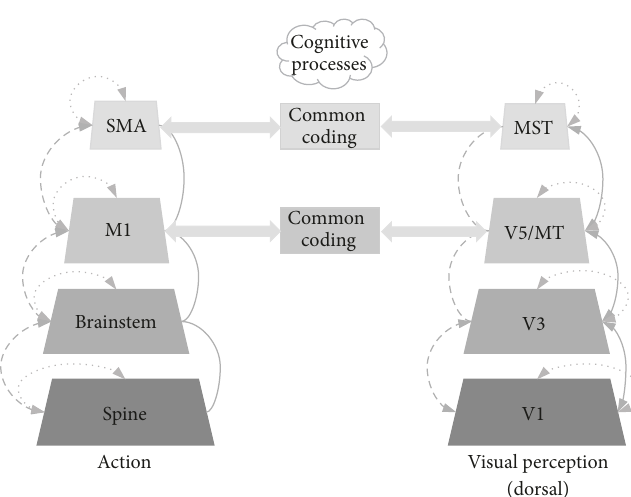
Figure 7: The process of cognitive